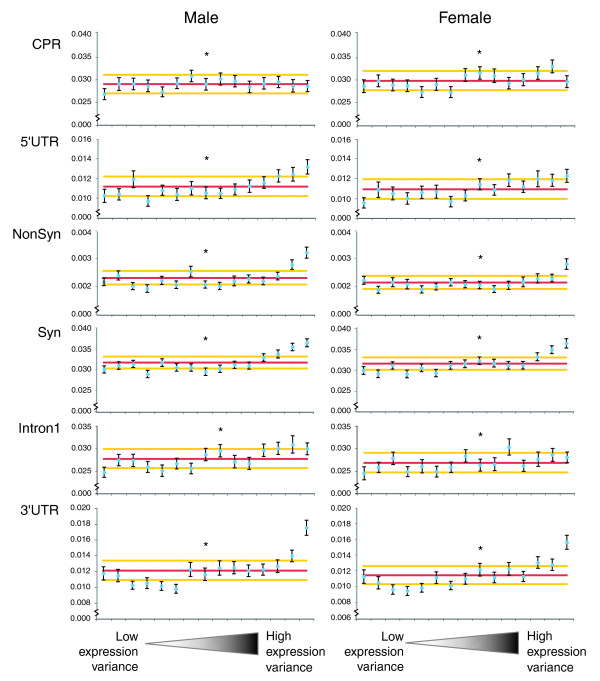
Significant expression variation between genotypes is associated with elevated levels of sequence polymorphism at most types of sites. The y-axis is the per site nucleotide diversity (note: axis scale varies by feature). The pink line indicates the genomic mean nucleotide diversity and yellow lines indicate 95% confidence intervals around the genomic mean. The x-axis represents the level of expression variation between genotypes for the different gene features as named (5'UTR, untranslated region; CPR, core promoter region; NonSyn, nonsynonymous sites; Syn, synonymous sites). P-values from the AOV of expression variation were sorted and grouped into 15 equal sized bins. Bins on the left side of the figure have no evidence of expression variation and bins on the right have the most variably expressed genes. For each bin, blue circles represent the mean nucleotide diversity with standard error bars. Permutation tests examined whether nucleotide diversity was higher within each bin than in a random sample of genes from the genome. The asterisk marks the bin in which an average p-value = 0.05 occurs. To the right of the asterisk, a positive trend is observed in some gene features, suggesting that the positive relationship between gene expression variation and nucleotide polymorphism is not solely confined to the most dramatically differentially expressed genes.